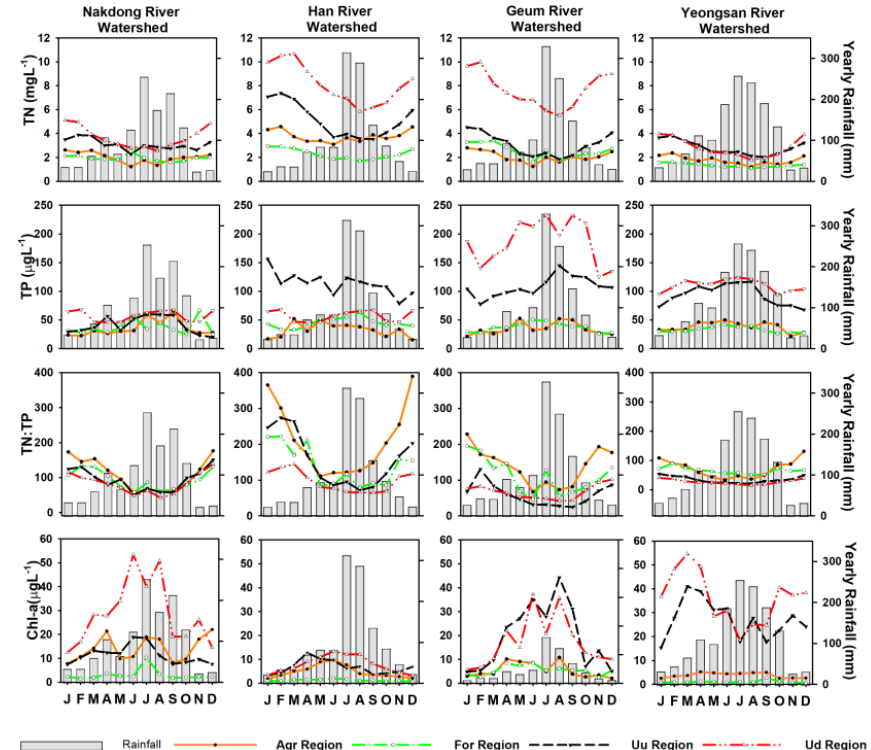
Figure 4. Seasonal patterns of total nitrogen (TN), total phosphorus (TP), Chlorophyll-a (Chl-a), and TN:TP ratios with monthly rainfall (mm) for 2016–2020 in 64 stream sites in each of the four land-use patterns divided into the four river watersheds.